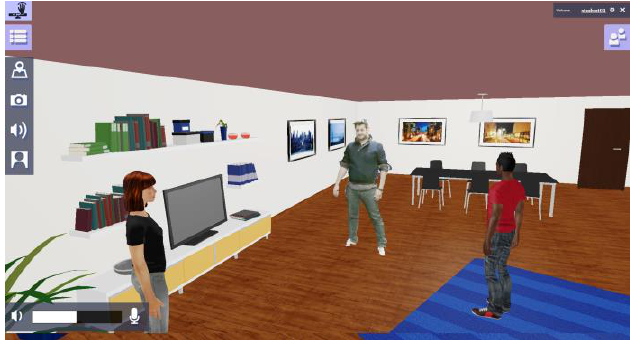
Figure 1. Virtual Hangout with one user represented as a real-time 3D reconstruction and the others as user-puppetted